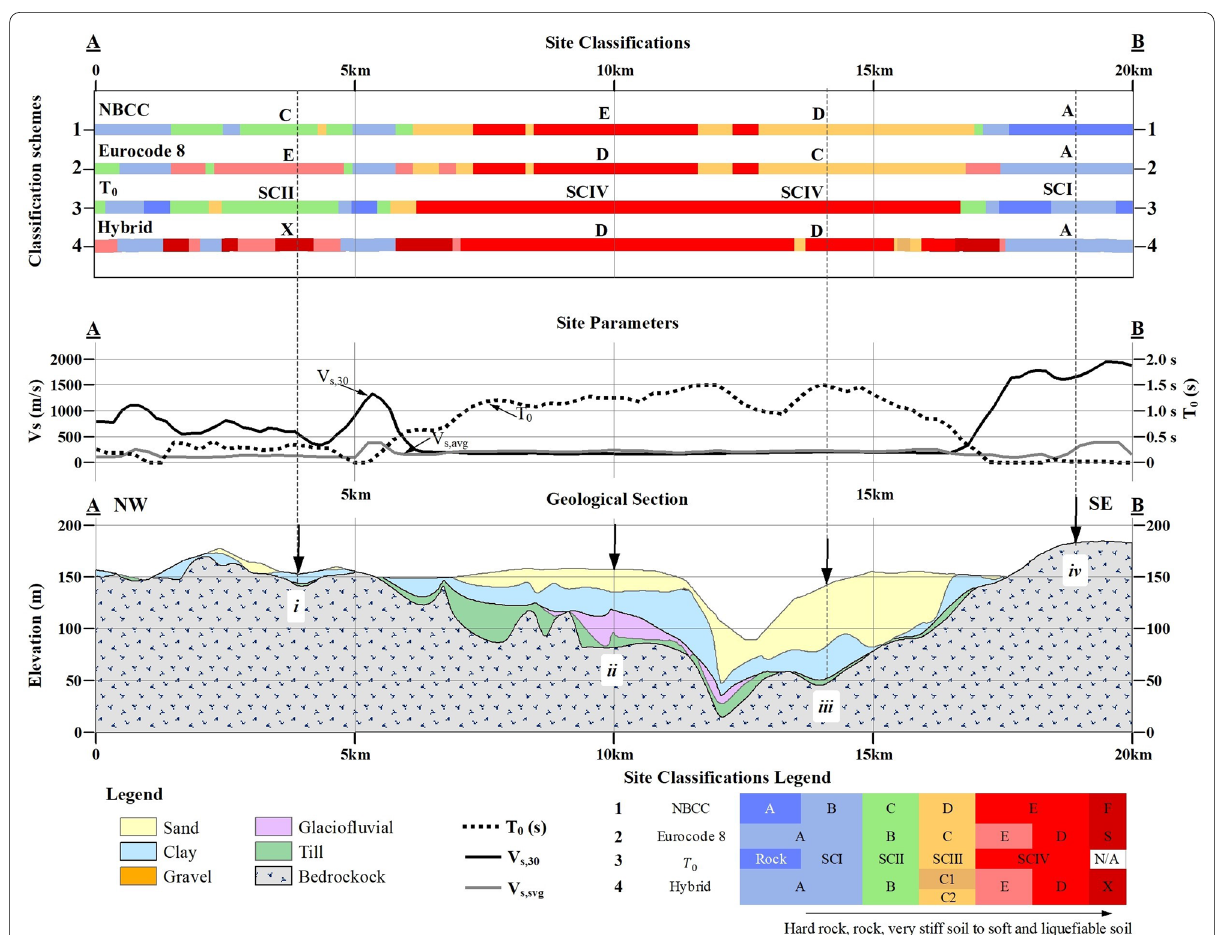
Fig. 6 Representative cross-section (from below): local geology with the four stratigraphic columns (i through iv), variation of the three main seismic parameters ( V s,30 , T 0 , V s,avg ), and the seismic site classification based on the four different schemes. The location of the cross-section is indicated in Fig. 3a